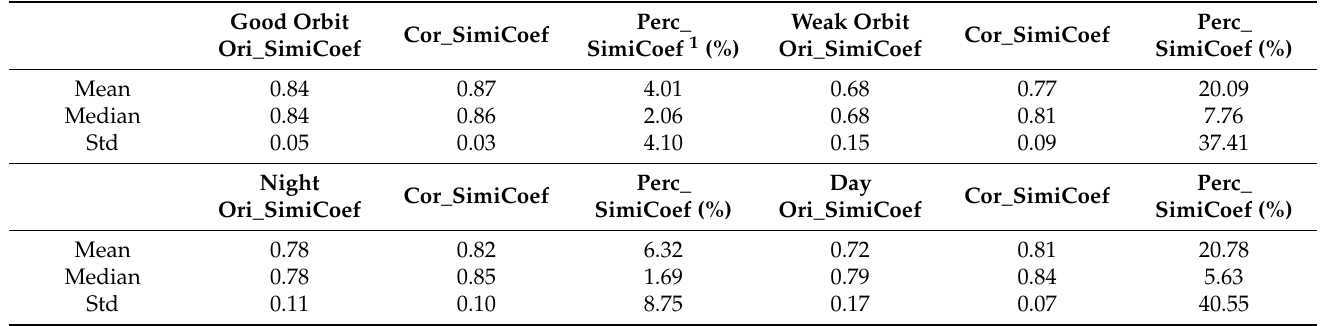
Table 5. Waveform similarity coefficient (R) around orbit quality and data time.